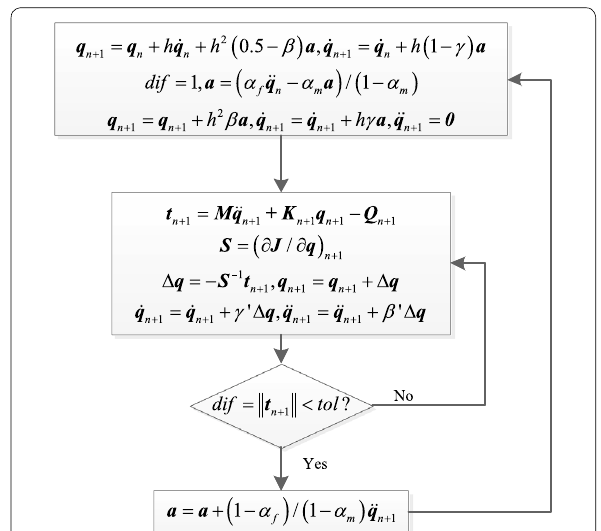
Figure 3 The numerical iteration procedure of the generalized-α algorithm